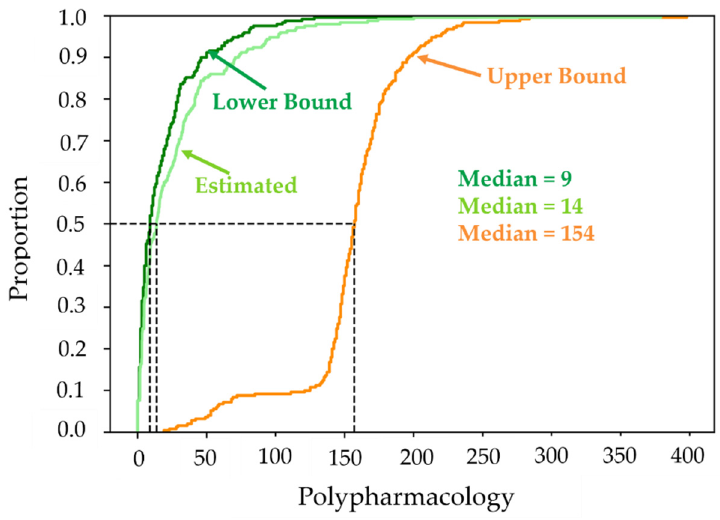
Figure 10. The cumulative distribution of the minimum, maximum, and estimated simple polyphar- macologies for all 250 ligands are displayed in dark green, orange, and lime green, respectively.